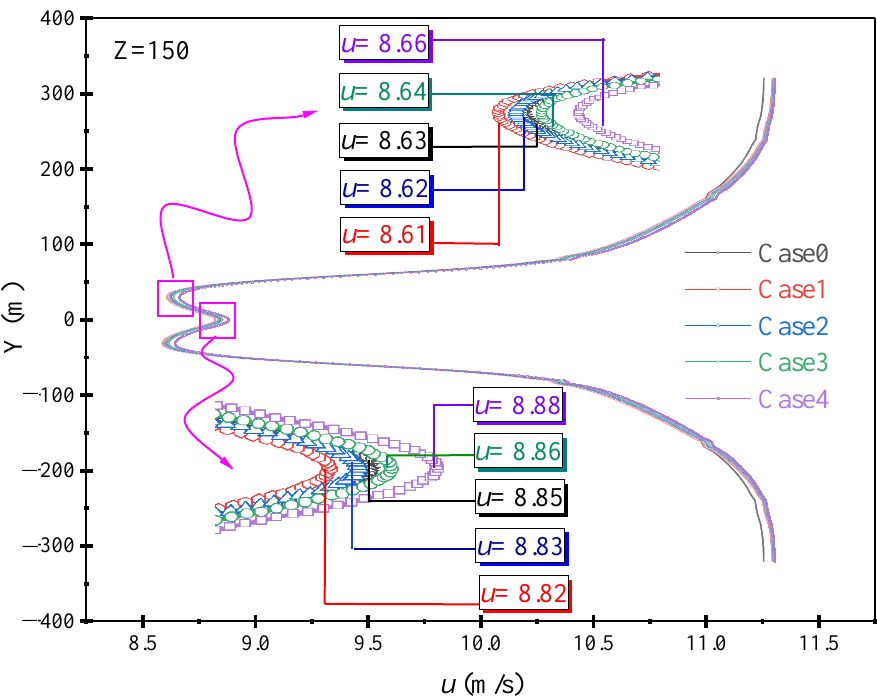
Figure 9. The effect of the change in the position of the small wind turbine on the wind speed from the large downstream wind turbine at Z = 150 m.